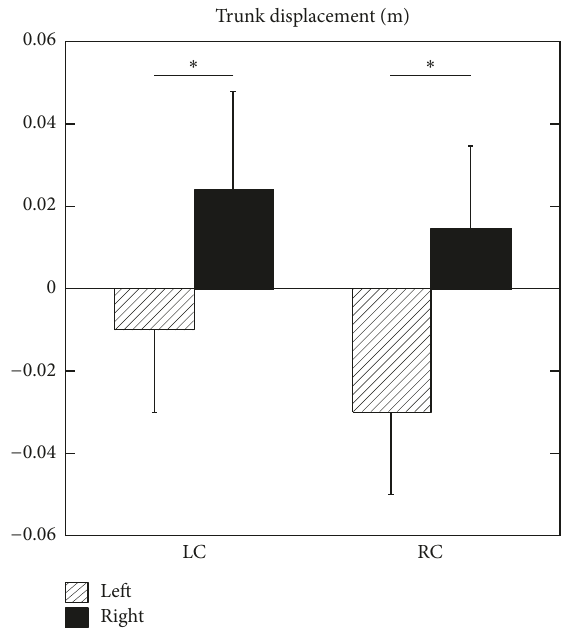
Figure 1: Maximum trunk displacement. LC: discomfort induced on the left side, RC: discomfort induced on the right side. L: left, R: right. ∗ shows statistical significance (𝑝 < 0.05)